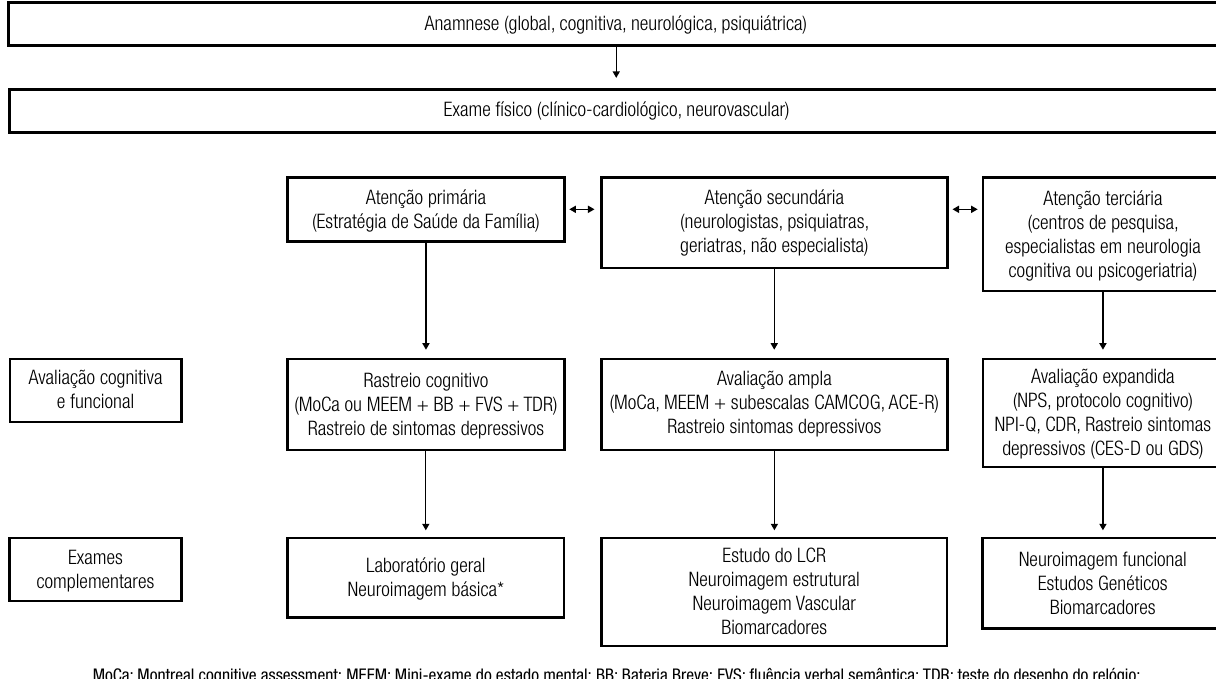
Figura 4. proposta de fluxograma para a avaliação e investigação de pacientes com suspeita de CCV / DV.